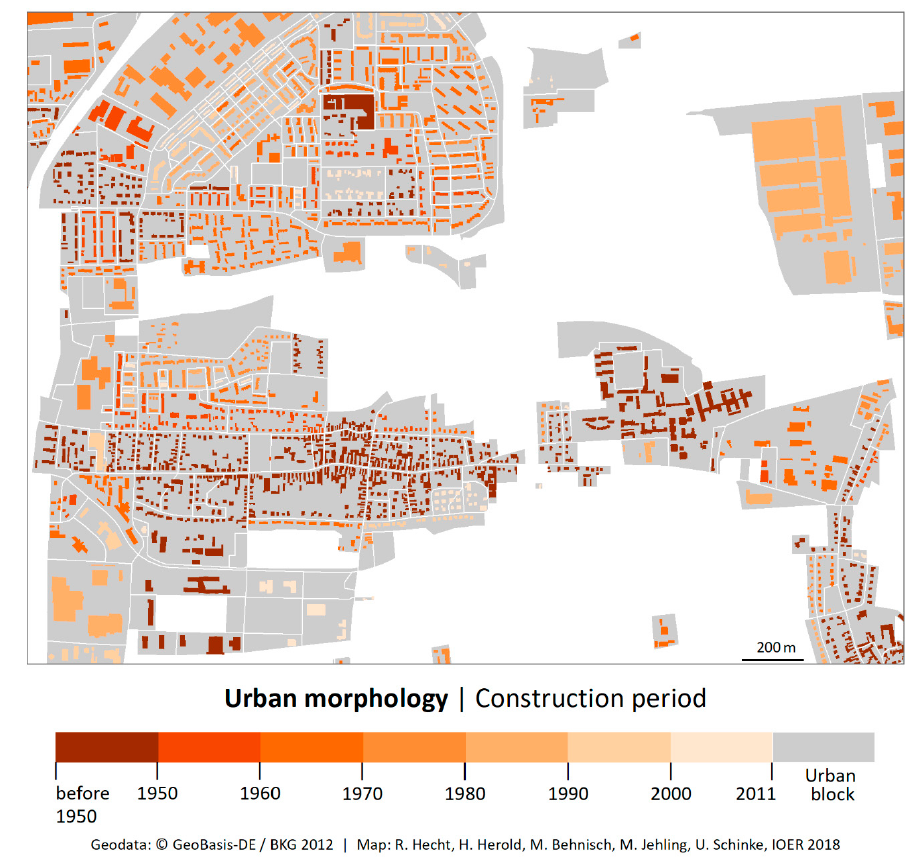
Figure 3. Period of construction derived by intersecting the historical settlement layer at the block level and the building footprints representing historical urban